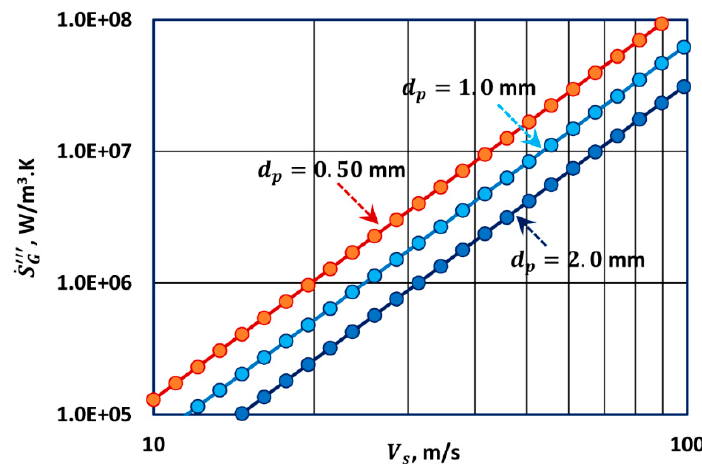
Figure 15. Effect of particle diameter on the rate of entropy generation per unit volume of the packed bed in turbulent flow ( T = 298.15 K, ε = 0.40, µ = 18.5 µ Pa · s, ρ = 1.184 kg / m 3 ). The data points are generated using Equation (52).